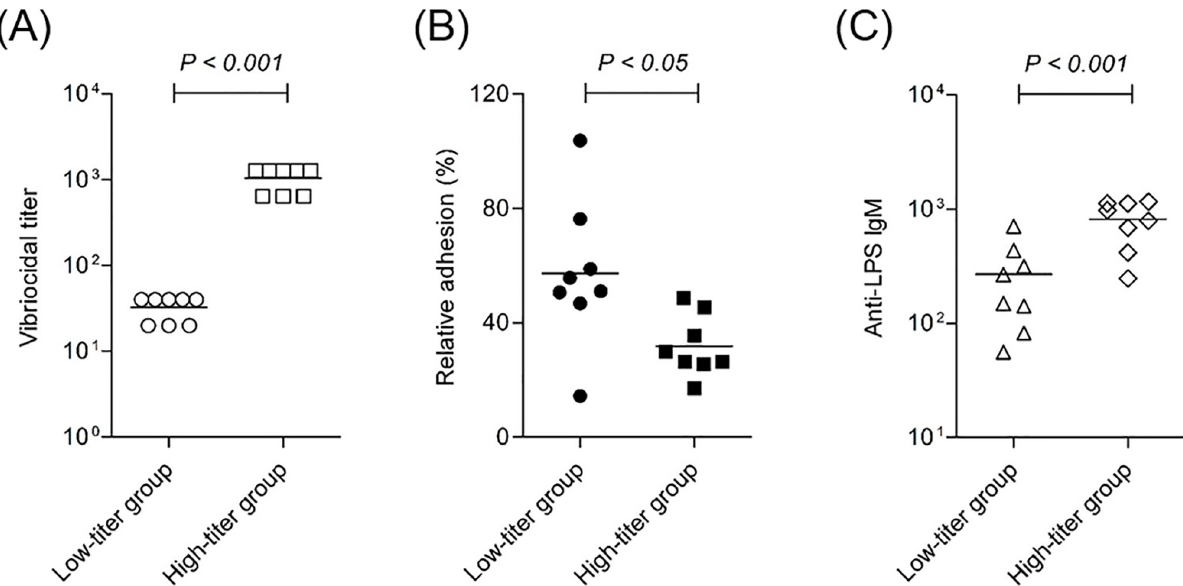
Fig 5. Clinical sera with high vibriocidal titer had a large amount of anti- V . cholerae LPS IgM and significantly inhibited bacterial adhesion to HT-29 cells. Sixteen sera containing low or high vibriocidal antibody (A) were examined for inhibitory activity of bacterial adhesion to HT-29 cells (B) and anti- V . cholerae LPS IgM level (C). To see the effect of clinical sera on bacterial adhesion to intestinal epithelial cells, HT-29 cells (2 × 10 5 cells/ml) were cultured in a 24-well plate for 8 days until cells reached confluence. V . cholerae O1 Inaba (10 6 CFU/ml) were pre-incubated with each clinical sera with low or high vibriocidal activity for 1 h, added to HT-29 cells, and then incubated for 1 h. HT-29 cells were washed with PBS and detached with 0.2% TritonX 100. Adherent bacteria were cultured overnight on LB agar plates and counted. Results are plotted as average of triplicates.